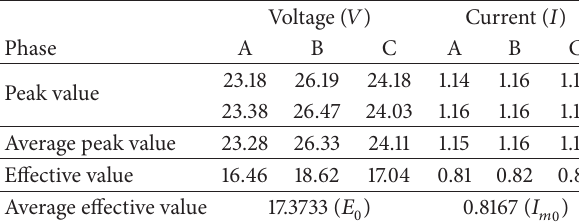
Table 4: Values of 𝐸 0 and 𝐼 𝑚0 .